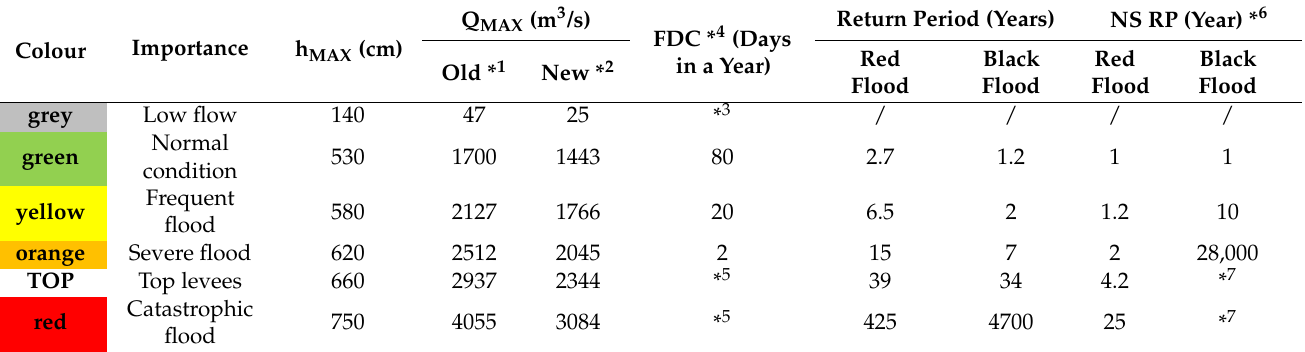
Table 5. Flood hazard thresholds (depth and flows) for the Niamey city and related return periods for red and black floods